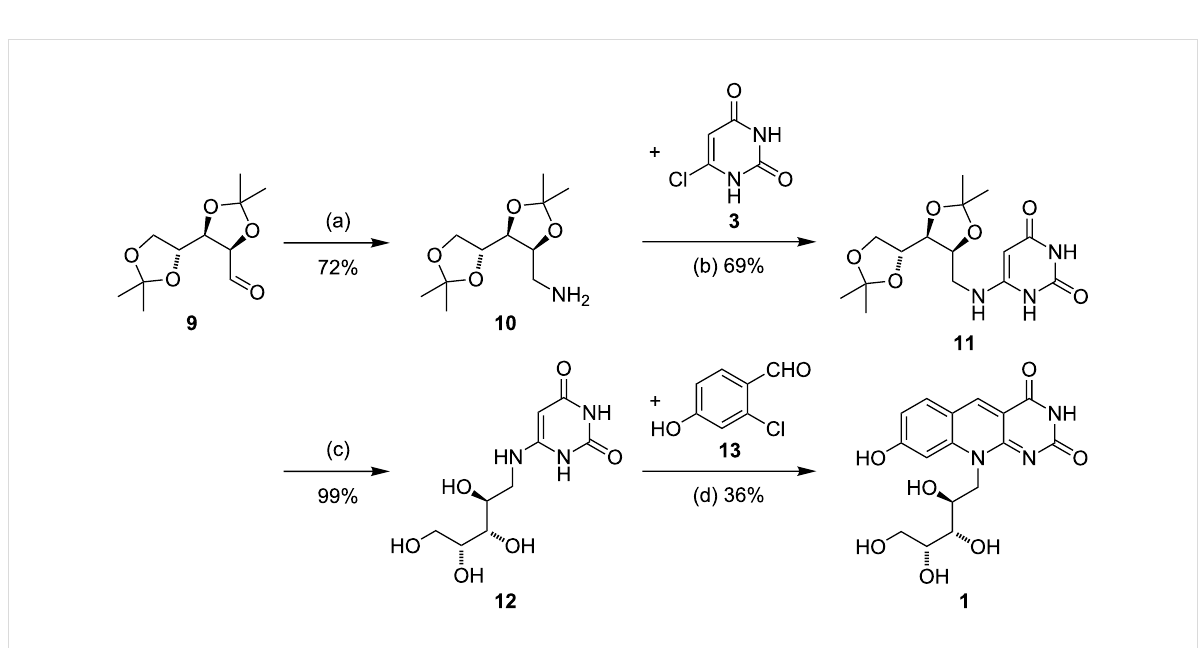
Scheme 3: Final four steps of the synthesis. Reagents and conditions: (a) 1. 4.5 equiv NH 2 OH·HCl, 4 equiv NaHCO 3 , EtOH/H 2 O (10:1), 23 °C, 16 h; 2. 5 equiv LiAlH 4 , THF, 67 °C, 4 h; (b) 1.2 equiv amine 10 , 1.0 equiv chlorouracil 3 , 2.0 equiv NEt 3 , EtOH, sealed reaction tube, 150 °C, 1.5 h (c)